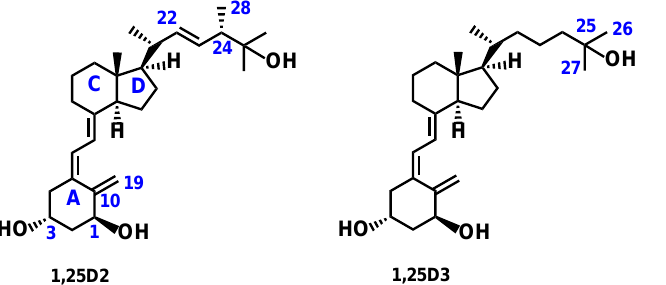
Figure 1. Structural formulas of 1 α ,25-dihydroxyergocalciferol (1,25-dihydroxyvitamin D 2 , 1,25D2) and 1 α ,25-dihydroxycholecalciferol (1,25-dihydroxyvitamin D 3 , 1,25D3).